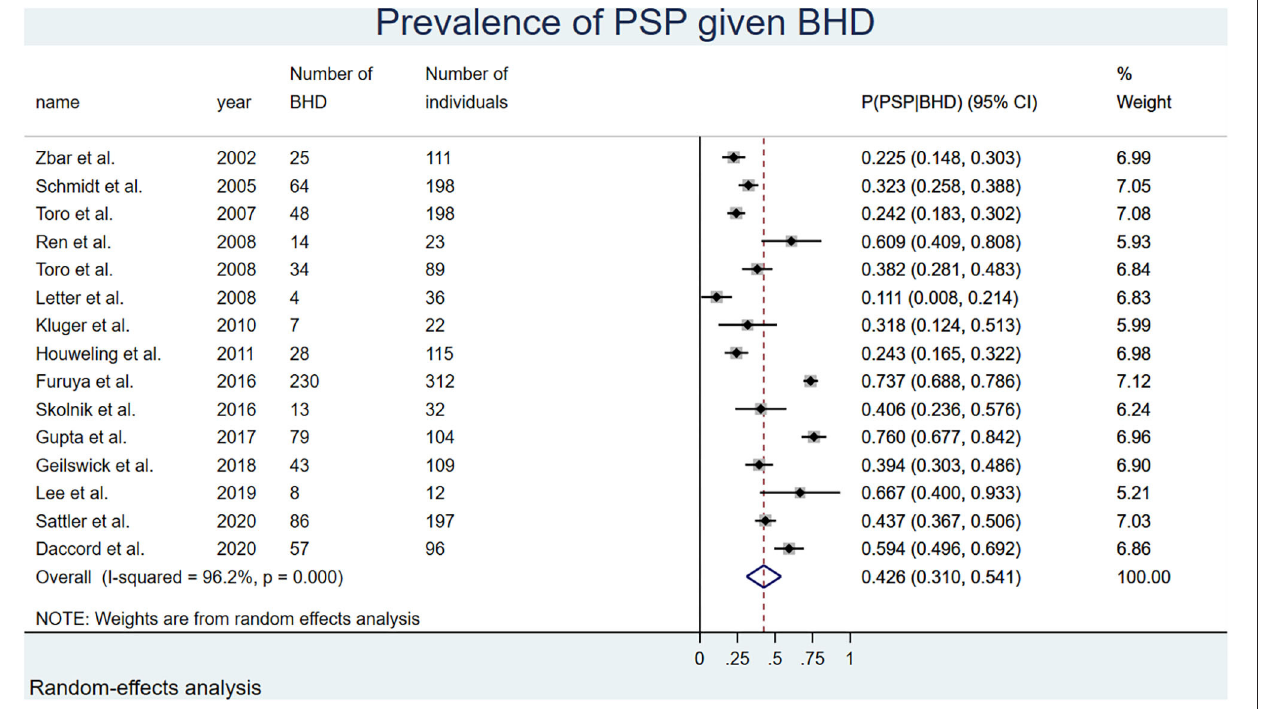
FIGURE 4 | Forest plot of the overall probability of pneumothorax in BHD, random-effects model. Only 15 studies were analyzed, as one study by Tobino et al. (39) included only